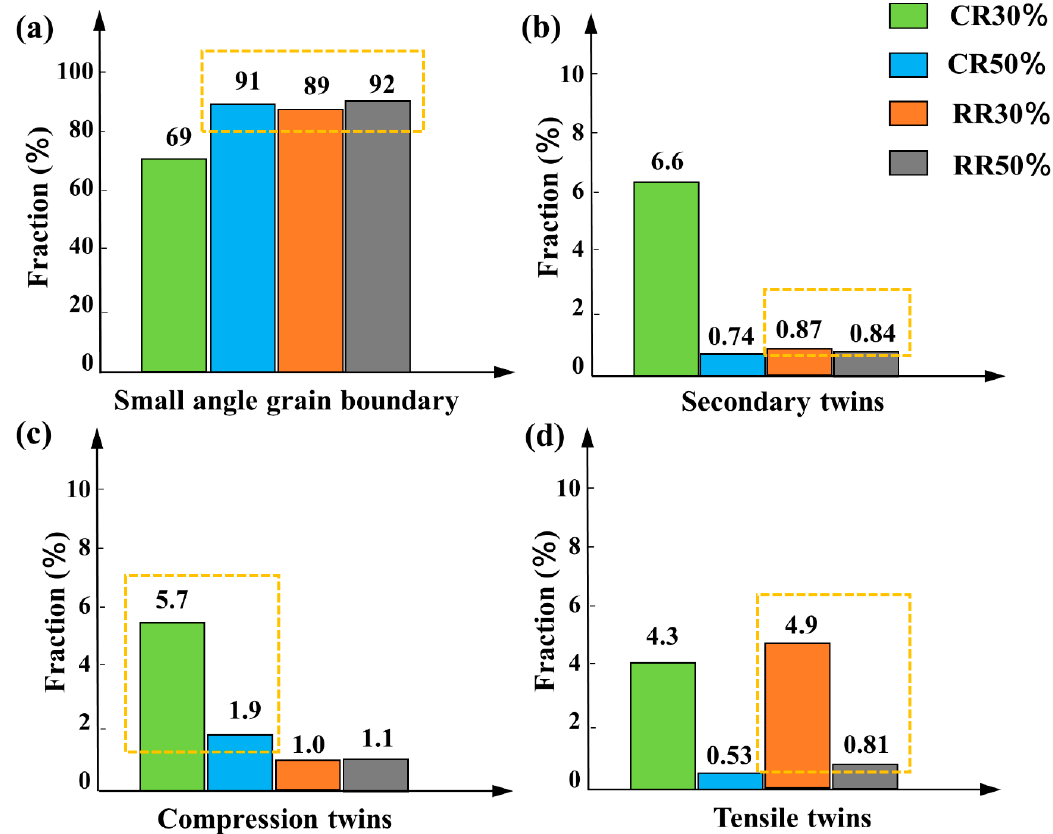
Figure 6. The content of ( a ) small-angle grain boundaries and ( b – d ) grain boundaries with three kinds of twin orientations of the CR30%, CR50%, RR30%, and RR50% plates.